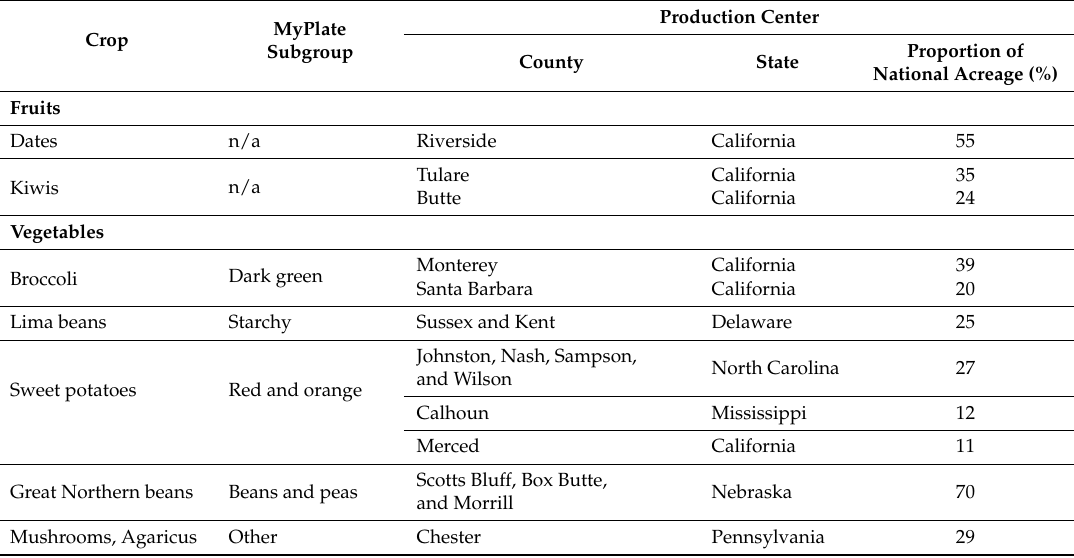
Table 1. National production centers of nutrient dense fruits and